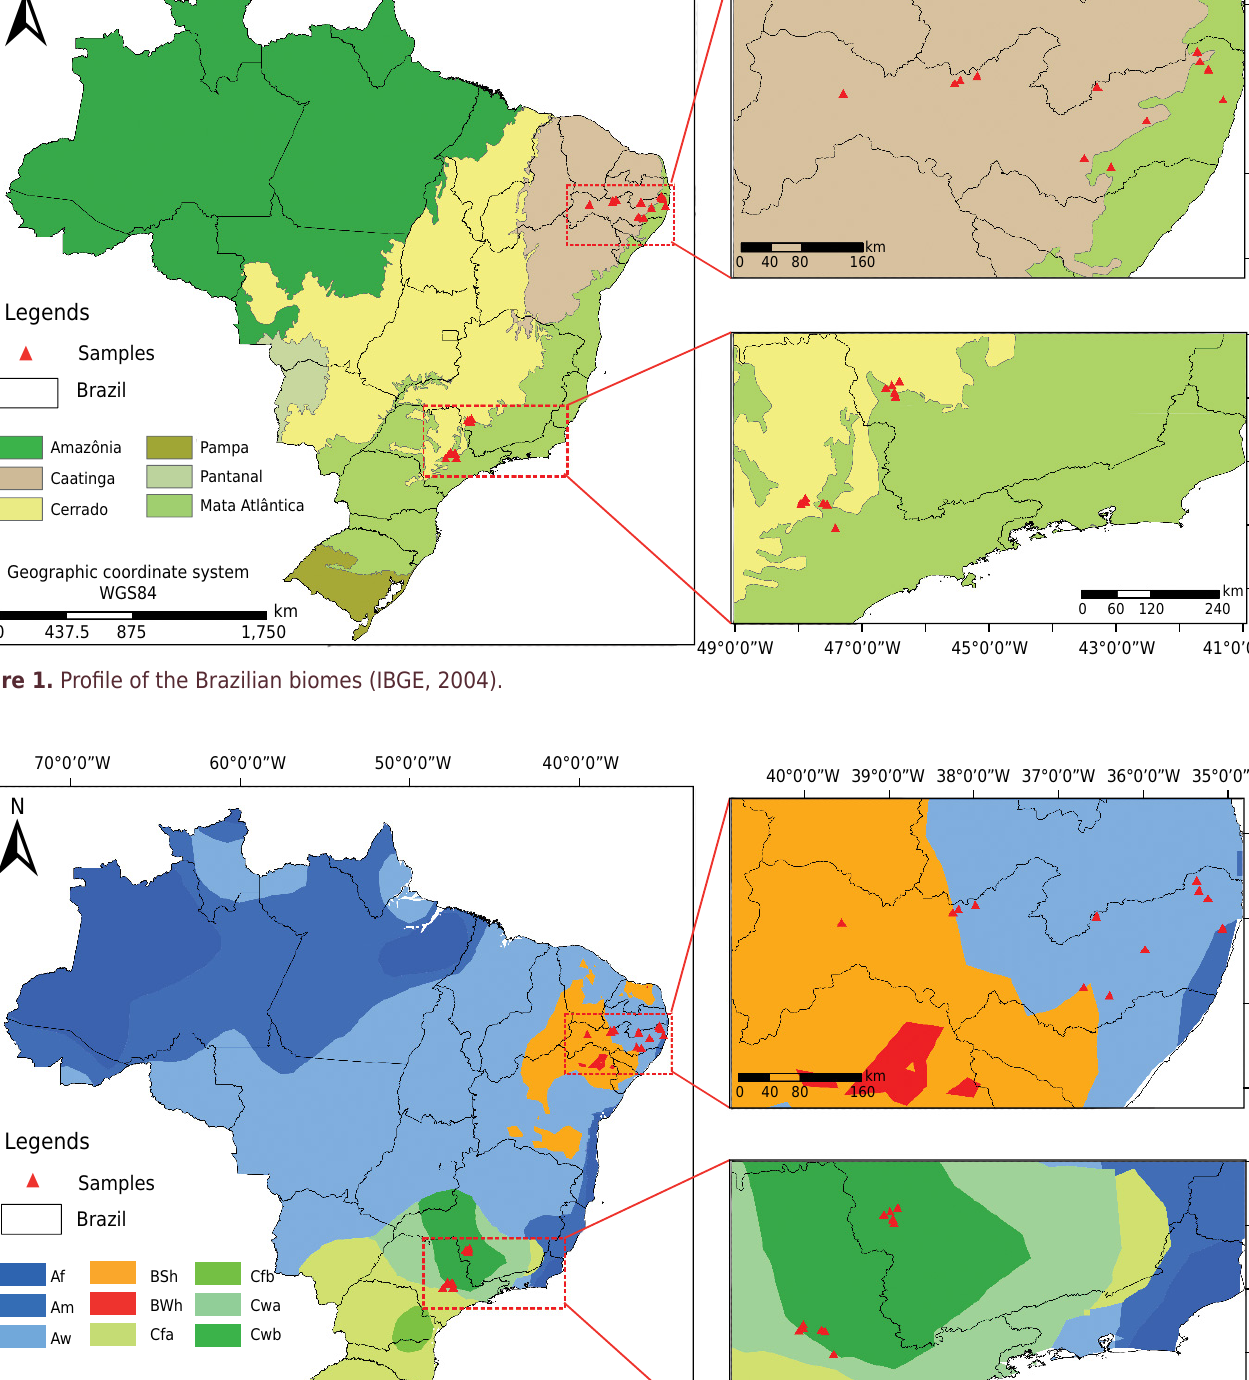
McKeague and Day (1966), respectively. The total elements (Fe Na O; P O ; and TiO ) were determined by digestion with acids (HNO 2 2 5 2 elements were determined by mass spectrometry (ICP-MS) in the extract.